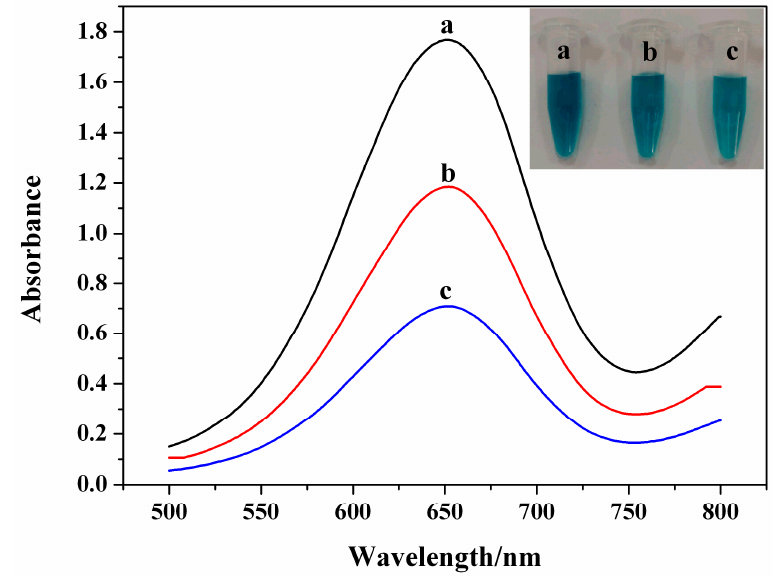
Figure 5. UV-VIS absorption spectrum of TMB at different concentrations of Ag + (a) 0; (b) 1.5 nM; and (c) 3.0 nM. Table 1. Comparison of the kinetic parameter of PtNPs before and after being treated with Ag + .